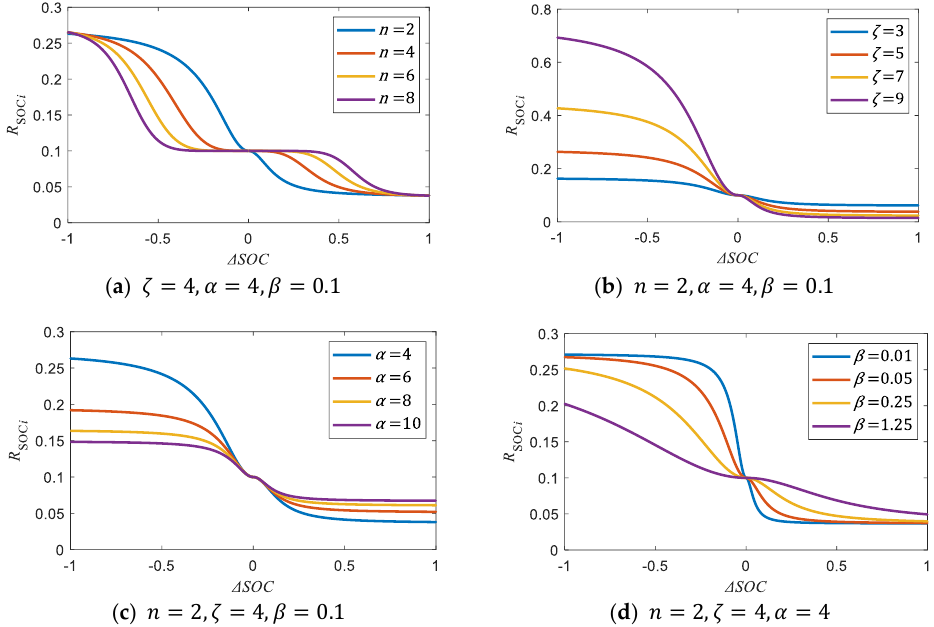
Figure 6. ∆𝑆𝑂𝐶 as a function of 𝑅 𝑆𝑂𝐶𝑖 for several factor set values. Figure 6. ∆ SOC as a function of R SOCi for several factor set